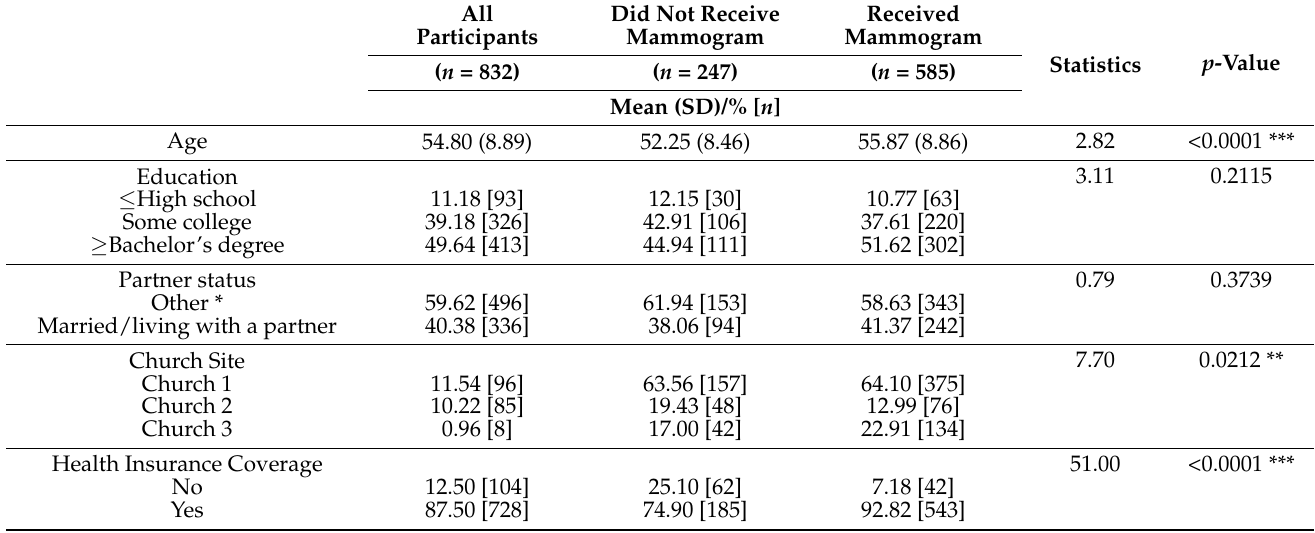
Table 1. Participant Characteristics Relative to Having Received a Mammogram Within the Last Year (N = 832 Black, church-going women over age